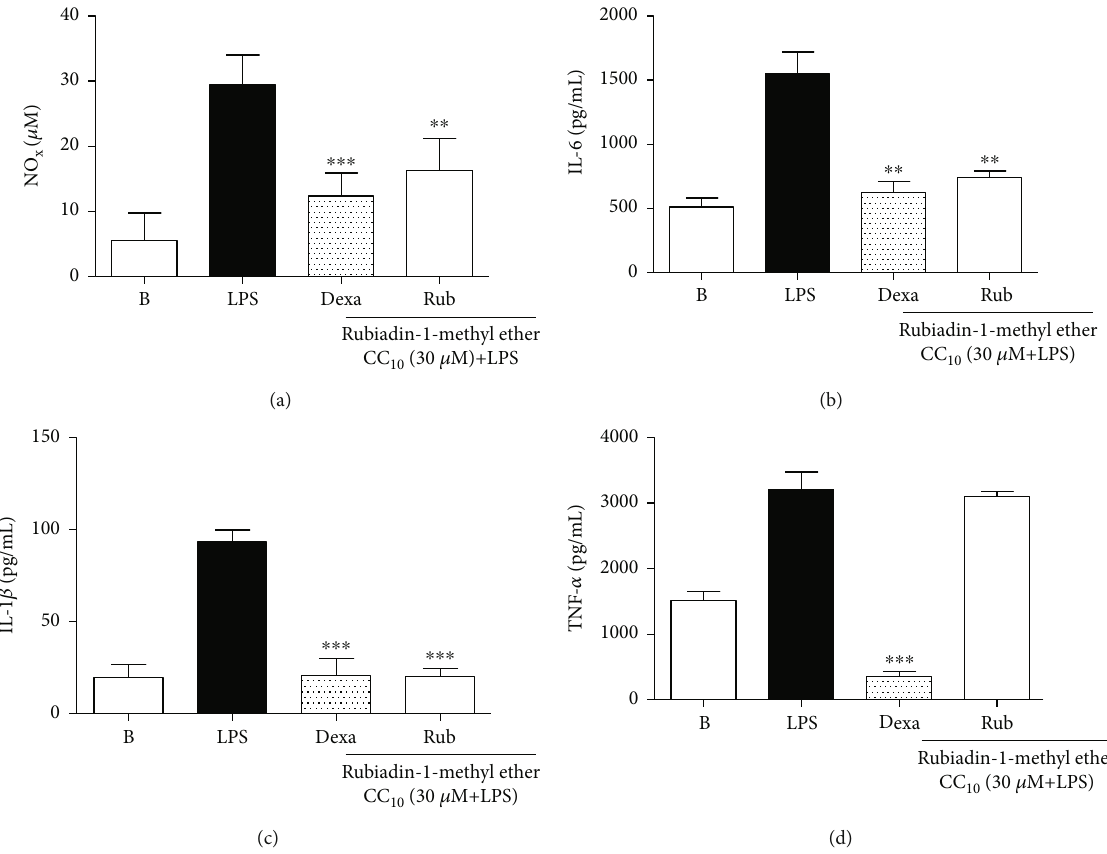
Figure 3: E ff ect of Rubiadin-1-methyl ether at 30 μ M dose on NOx (a), IL-6 (b), IL-1 β (c), and TNF- α secretion (d) in RAW 264.7 macrophages stimulated with LPS. B: cells pretreated with vehicle and stimulated with PBS; LPS: cells stimulated with LPS (1 μ g/mL); Dexa: cells pretreated with Dexamethasone (7 μ M) and stimulated with LPS (1 μ g/mL); Rub: cells pretreated with Rubiadin-1-methyl ether at 30 μ M and stimulated with LPS (1 μ g/mL). The results were expressed as the mean ± S : D : ; n = 3 ; ∗∗ P < 0 : 01 and ∗∗∗ P < 0 : 001 compared with the LPS group.